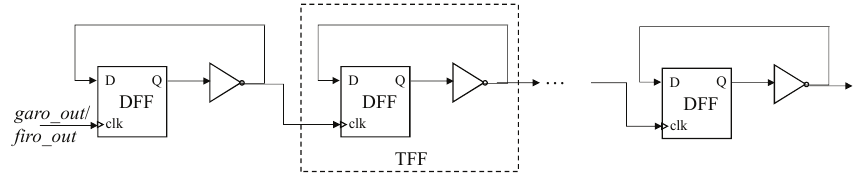
Figure 11: The architecture of an asynchronous counter.